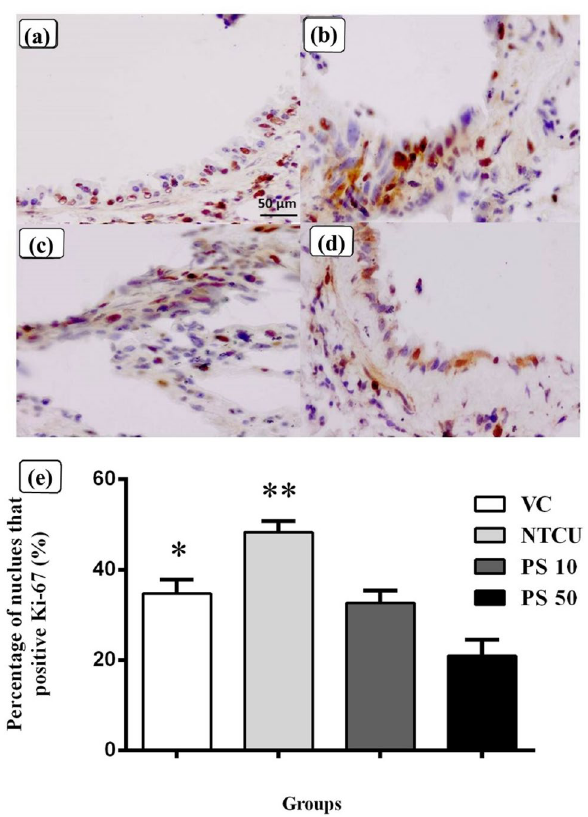
layer compared to ( b ) of the NTCU group. ( e ) showed the quantification of cell proliferation activities using the percentage of nucleus that was positive for Ki-67 (immunopositive cells) per total number of nuclei at the bronchial epithelium layer. Data are presented as mean ± SEM. *Statistically significant differences between VC and NTCU and PS 50 ( p < 0.05). **Statistically significant differences between NTCU and PS 10 and PS 50 ( p <